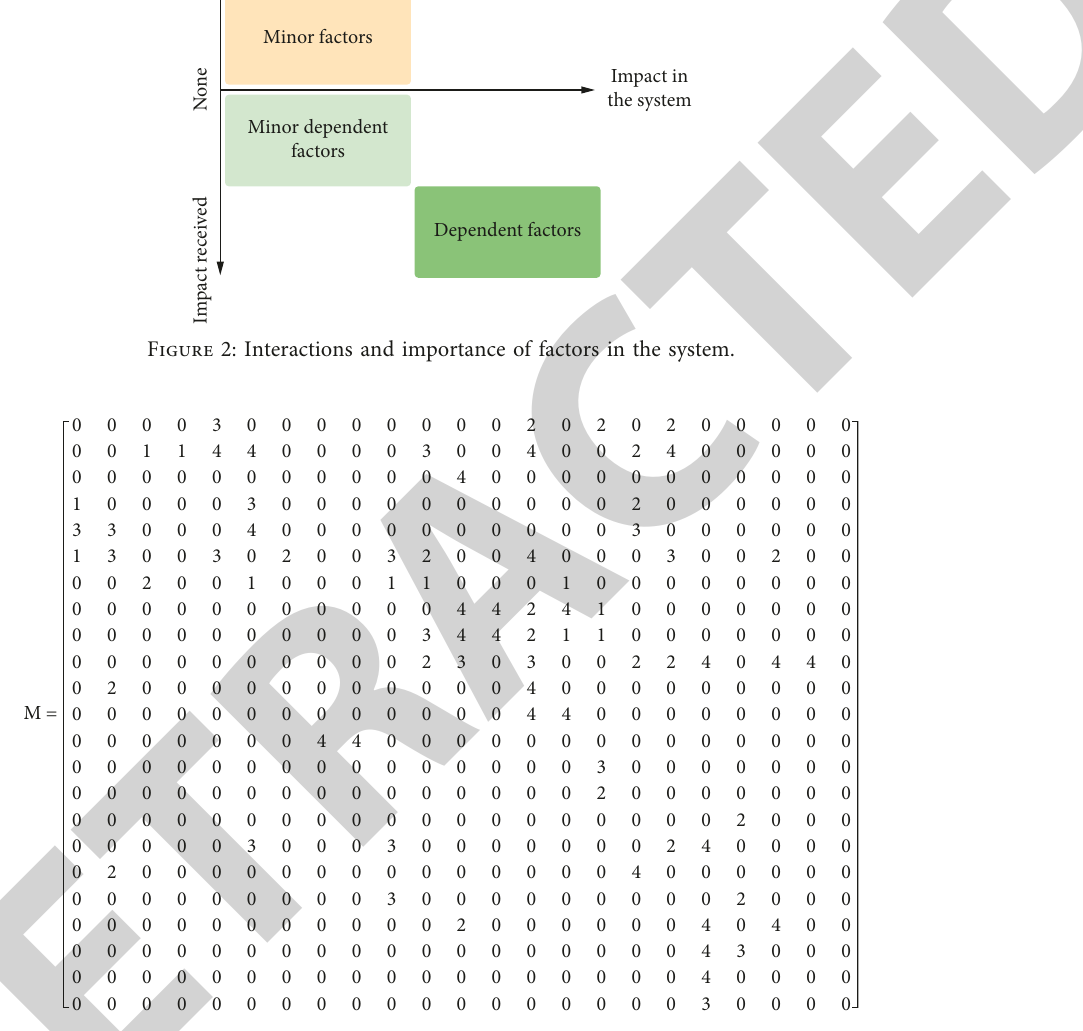
Figure 3: Relation matrix